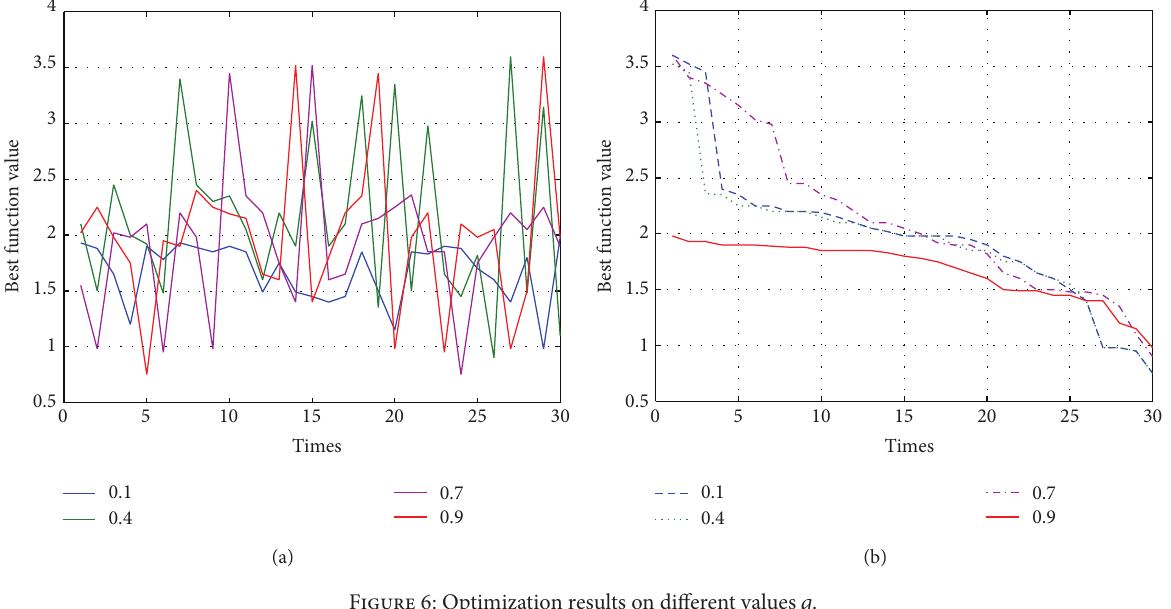
Figure 6: Optimization results on different values 𝑞 . Table 5: The results with different 𝑞 (cost: million yuan, CPU time: second).